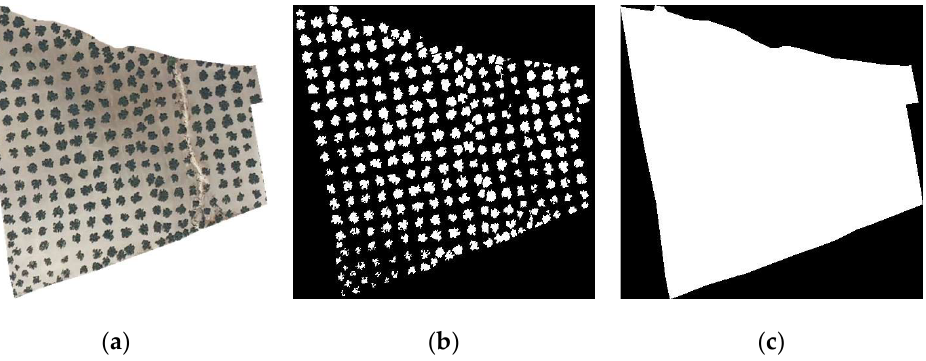
Figure 3. Example of the images downloaded for a crop: ( a ) Image downloaded from the PNOA for a traditional olive crop (Grove); ( b ) Image processed with the FCC (Grove FCC); ( c ) Image with the delimitation of the olive crop (Grove mask).